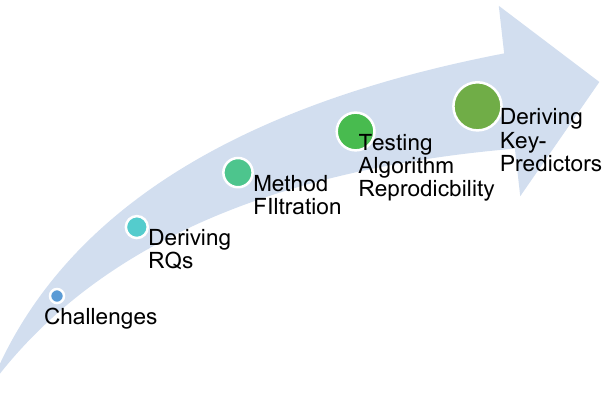
Figure 1. Incremental Evaluation process for Key- Predictors Identification.